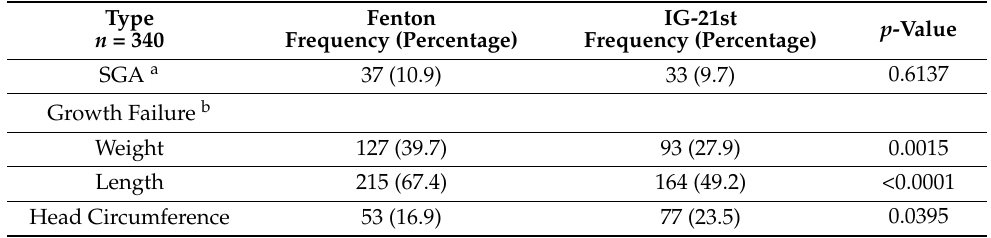
Table 2. SGA(small for gestational age) and growth failure identification at discharge by